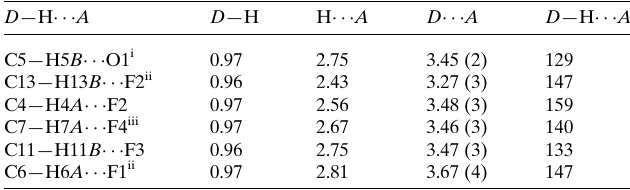
Table 1 Hydrogen-bond geometry (A˚ , (cid:5) ).